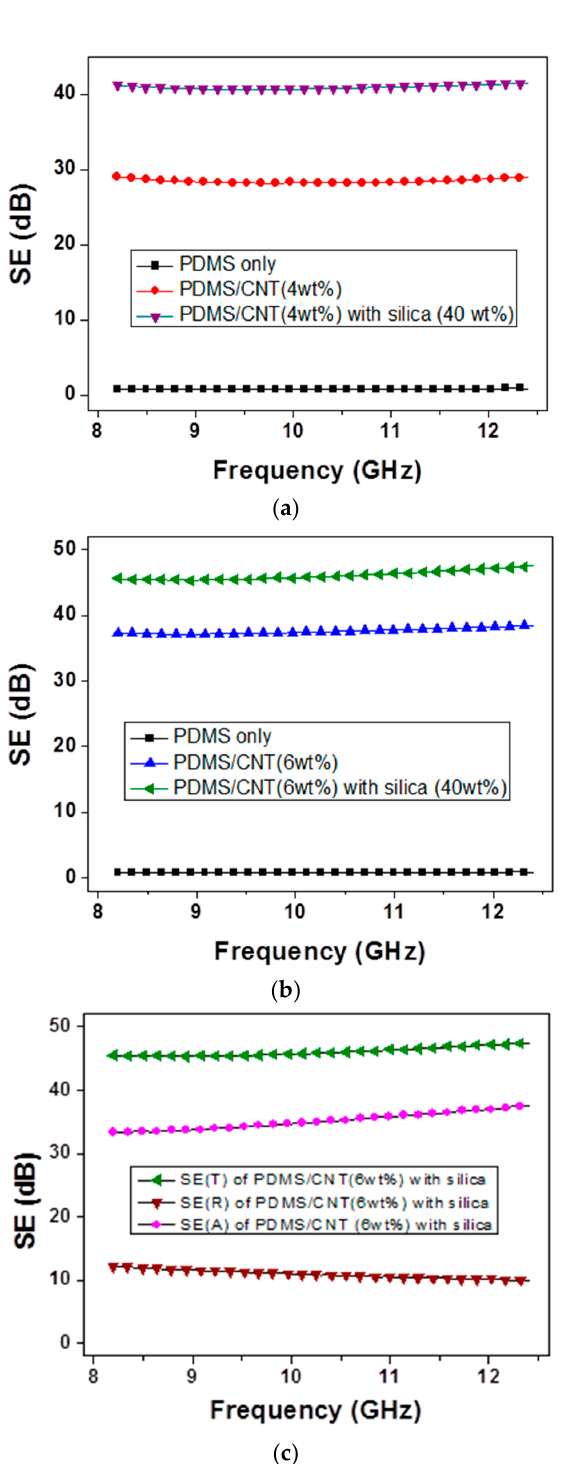
Figure 7. Comparison of EMI SE of CNT/micro-silica/PDMS and CNT/PDMS composites, ( a ) with 4 wt% CNT, and ( b ) with 6 wt% CNT. ( c ) Total SE of CNT/micro-silica/PDMS (6 wt% CNT) can be decomposed into contributions from absorption, SE(A) and reflection, SE(R).